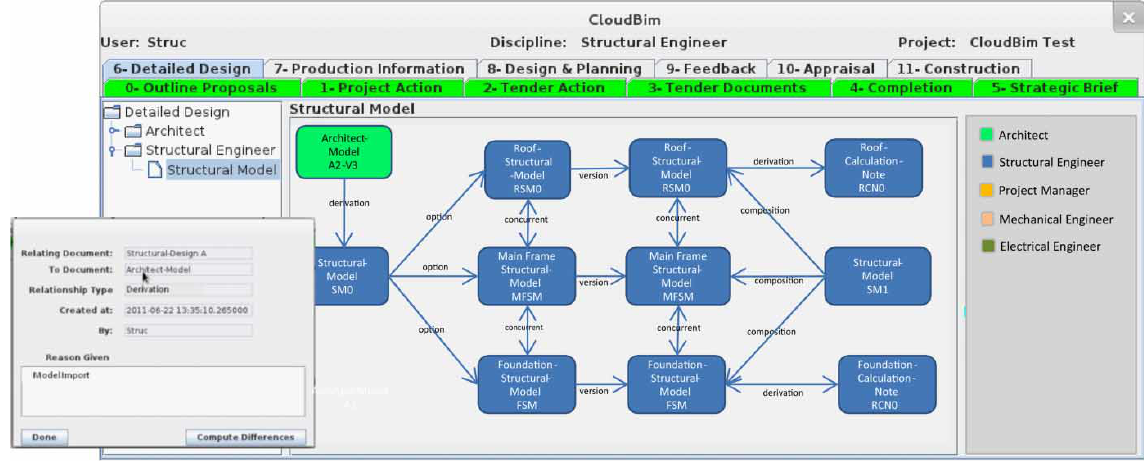
Fig. 12. Structural design progress management